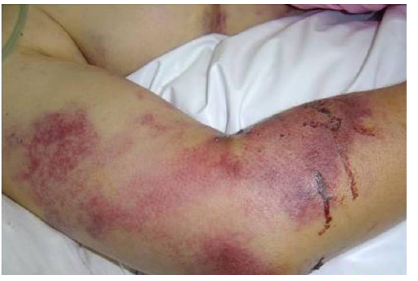
Figure 5 . Wide-Spread Swelling and ecchimosis on the Right Arm Due to